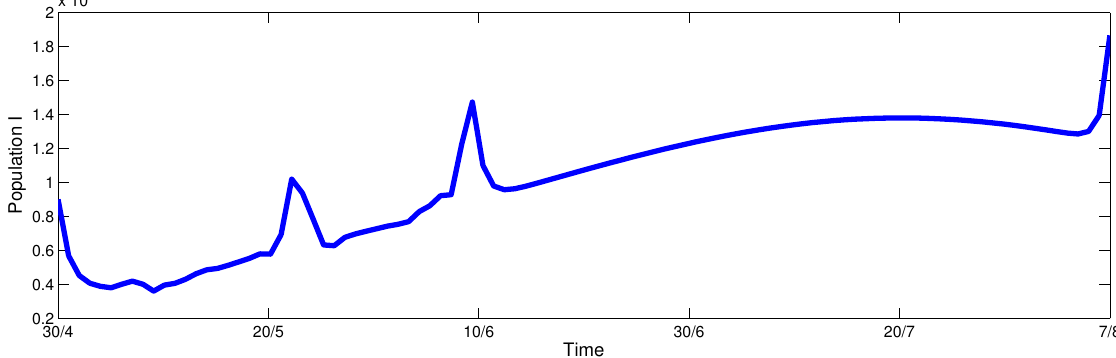
Fig. 8. The control diagram for the infected population ( I ) using data given in Table 1 along with G 1 = 0 . 005 and G 2 = 1000 from 30 / 4 / 2020 to 7 / 8 / 2020 .